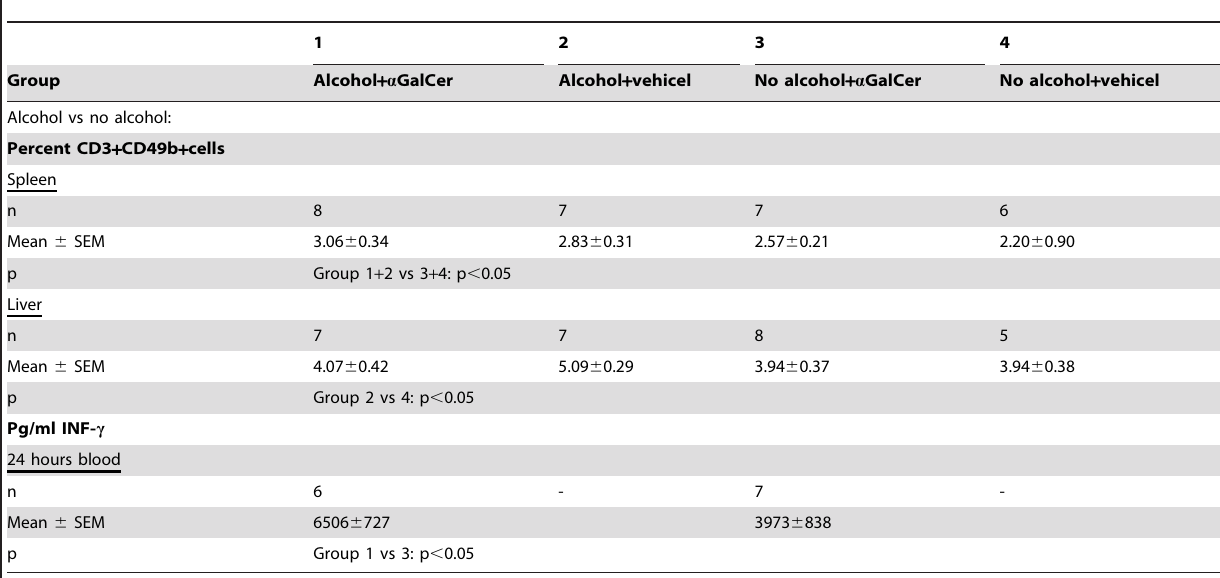
Table 1. NOD mice with 5% ethanol v/v in the drinking water had a significantly higher number of NKT cells (CD3 + CD49b + cells) in both liver and spleen and a significantly higher concentration of IFN- c in their 24 hour blood samples compared to NOD mice without ethanol in their drinking